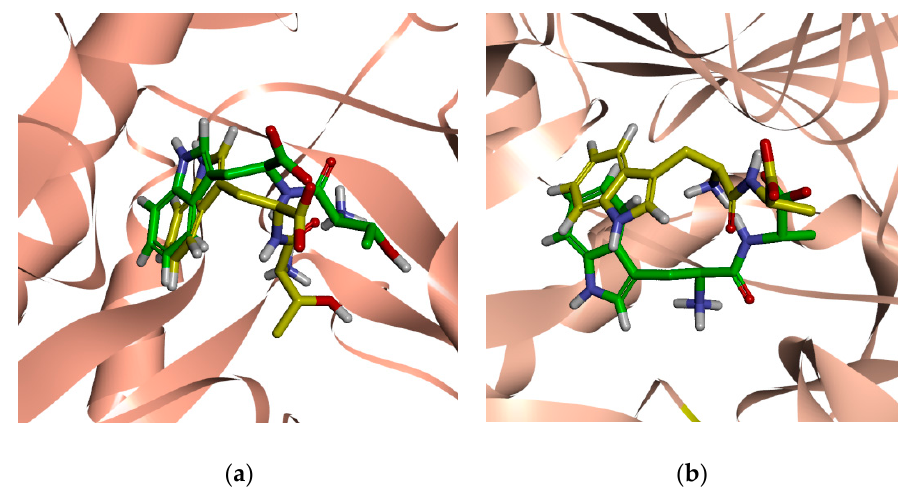
Figure 3. ( a ) The cartoon mode of the representative structure of cluster 1 (yellow) and cluster 2 (green) from MGAM-TW complex and ( b ) the cartoon mode of the representative structure of cluster 1 (yellow) and cluster 2 (green) from MGAM-WA complex.